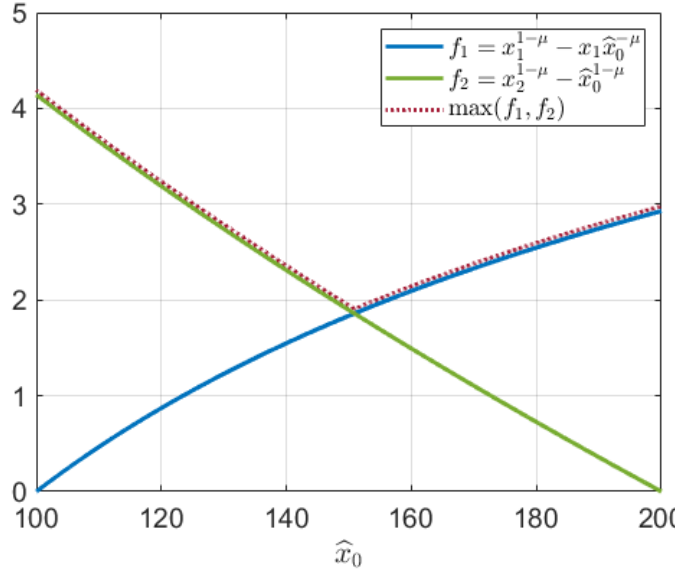
Figure 2. Illustration of Theorem 1 for x 1 = 100, x 2 = 200, and µ = 1